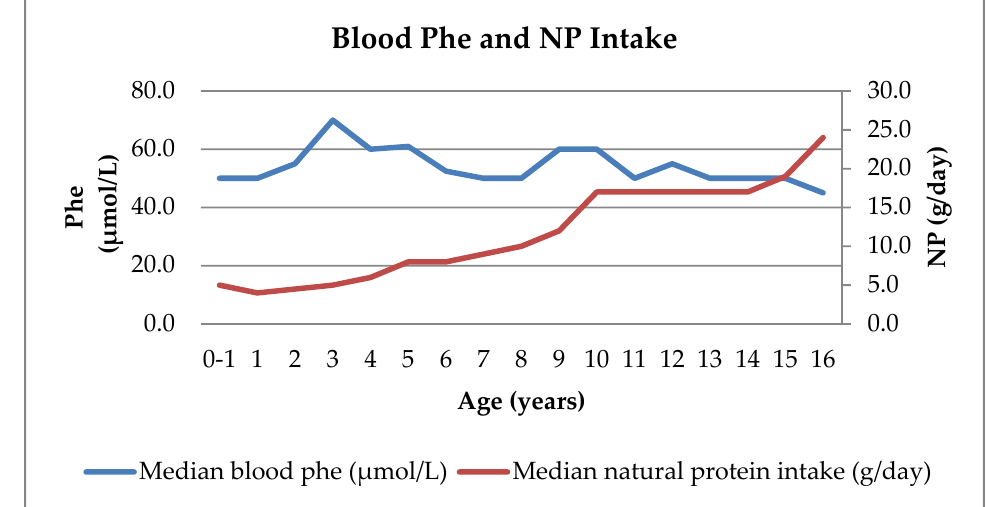
Figure 4. Median blood Phe concentrations and NP intake by age in patients with HTI.